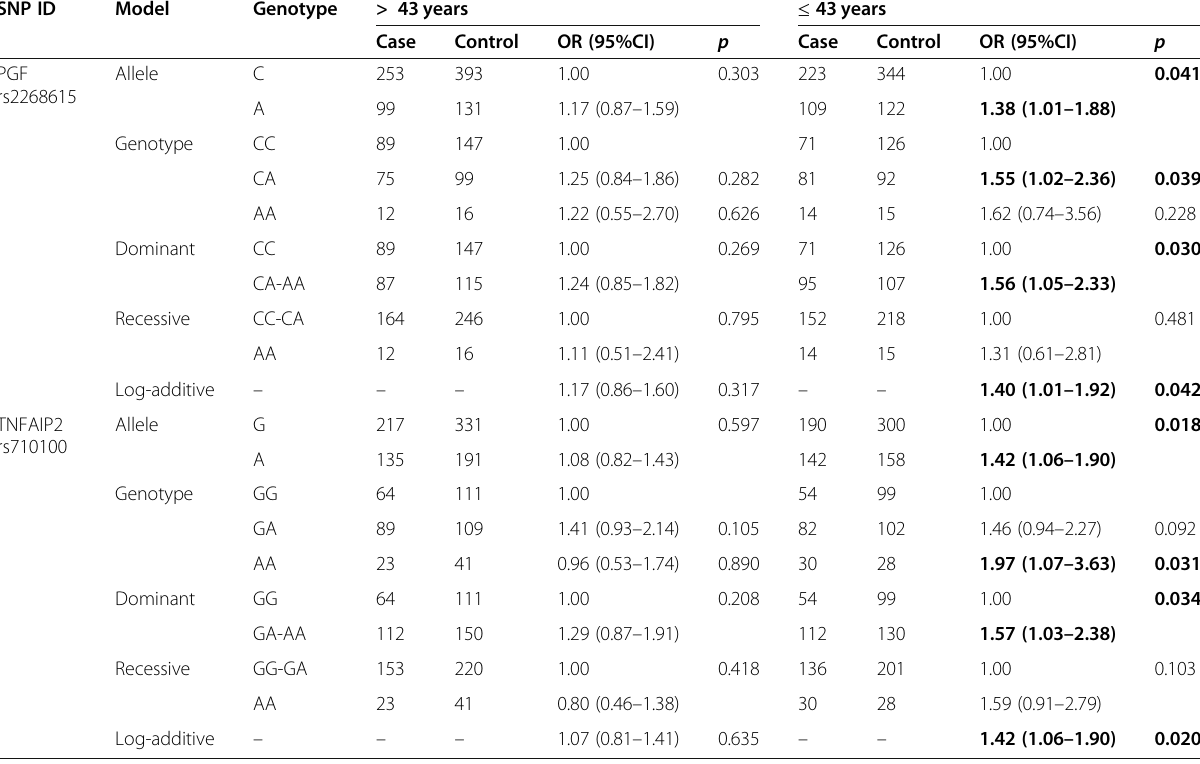
Table 3 Relationships between the candidate SNPs and cervical cancer risk according to the stratification by age SNP ID